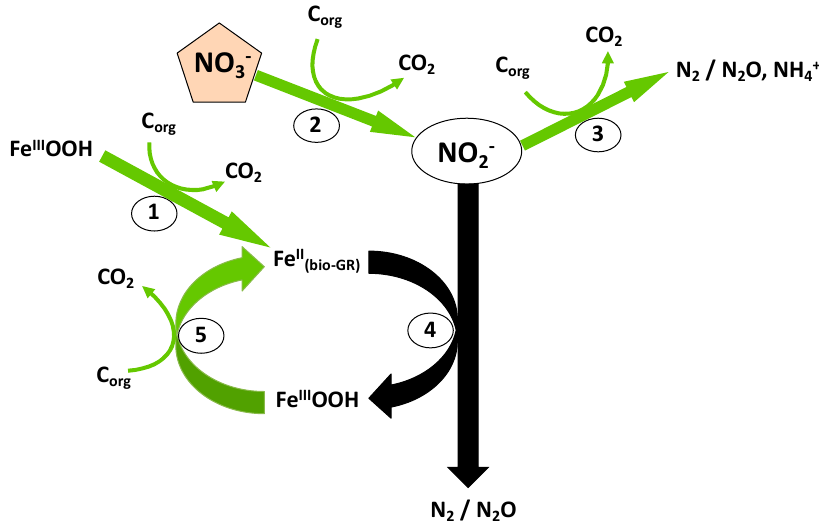
Figure 9. Schematic diagram presenting the coupling between bacterial nitrate reduction and abiotic nitrite conversion into gaseous nitrogen species by biogenic hydroxycarbonate green rust, referred to as “bio-GR(CO 3 )”. Reactions are numbered from 1 to 5: step 1: bio-GR(CO 3 ) formation upon reduction of ferric oxyhydroxides by Shewanella spp. [35]; step 2: bacterial nitrate reduction by Shewanella spp. or other heterotrophic bacteria inducing the accumulation of nitrite; step 3: bacterial nitrite reduction by Shewanella spp. or other heterotrophic bacteria into ammonium and N 2 /N 2 O; step 4: abiotic nitrite